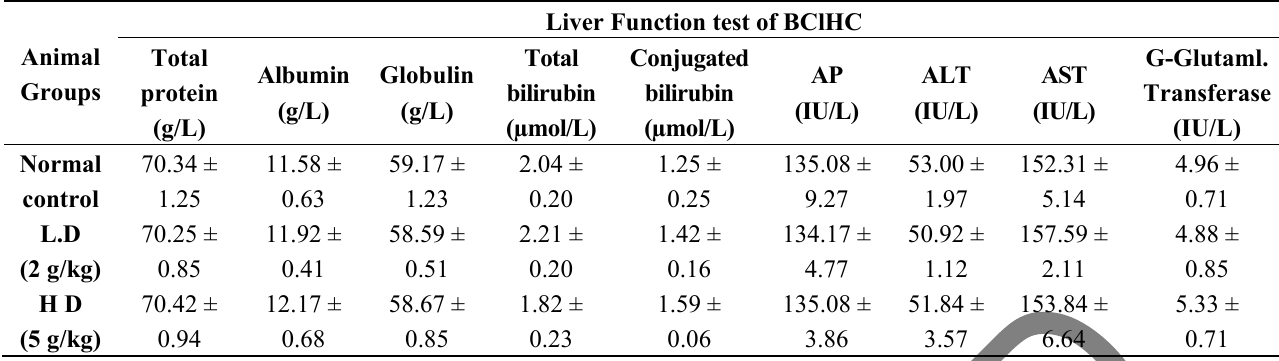
Liver Function test of BClHC Conjugated bilirubin